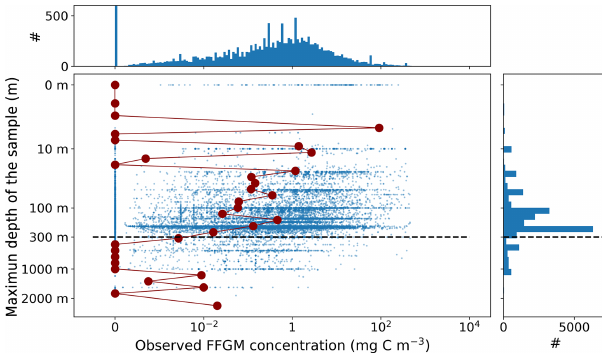
Figure A2. Depth–biomass scatter plot and histogram of FFGM observed biomass and maximal depth of the samples from the At- lantECO dataset before excluding deep samples (Sect. 2.4.1). Blue points are samples. The red dots represent the median biomass per depth